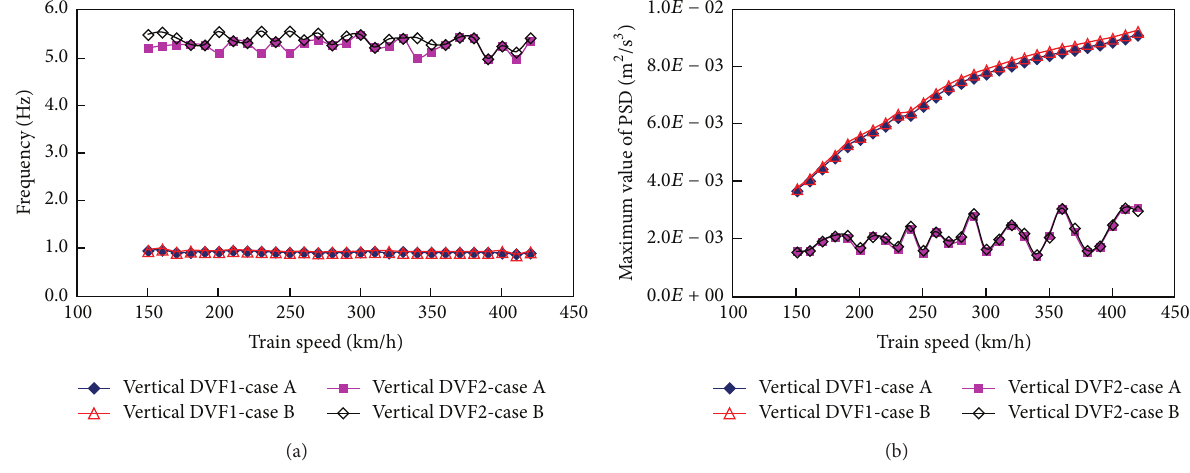
Figure 7: Motor carbody vertical acceleration with respect to train speed. (a) DVF. (b) Maximum value of PSD.